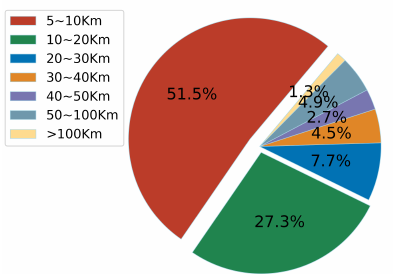
Figure 7. The distribution proportions of the different radius craters in the Head-LROC catalog [9,10]. In the experiment, the original crater images and ground-truth images were generated sets, validation sets, and test sets were 30,000 DEM images, 3000, and 3000,